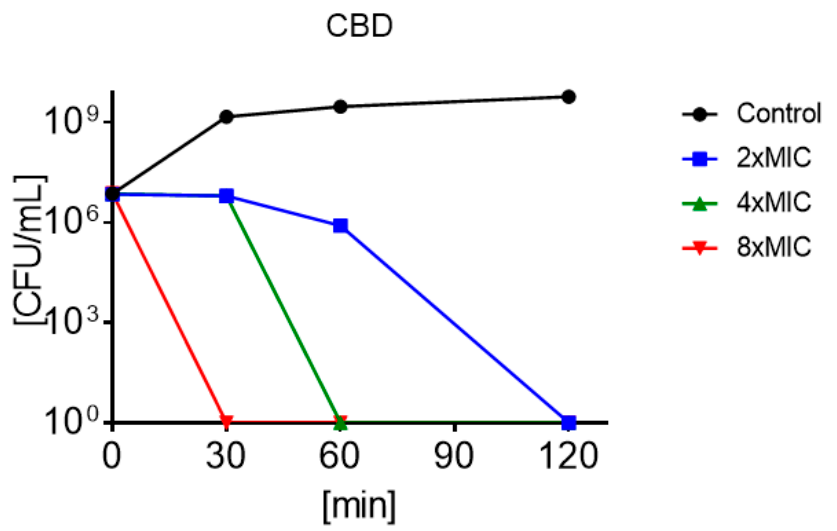
Figure 3. Time kill profiles of MRSA under treatment of 2 × minimum inhibitory concentration (MIC) ( ■ ), 4 × MIC ( ▲ ), and 8 × MIC ( ▼ ) of CBD and untreated control ( ● ).